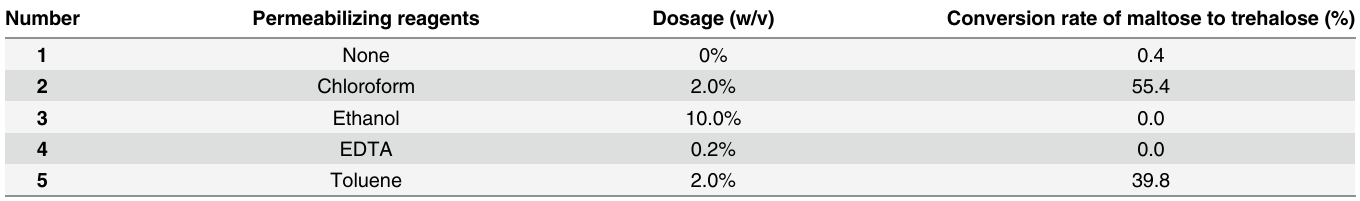
Table 1. Effects of permeabilization treatment on the conversion rate of maltose to trehalose by various reagents.